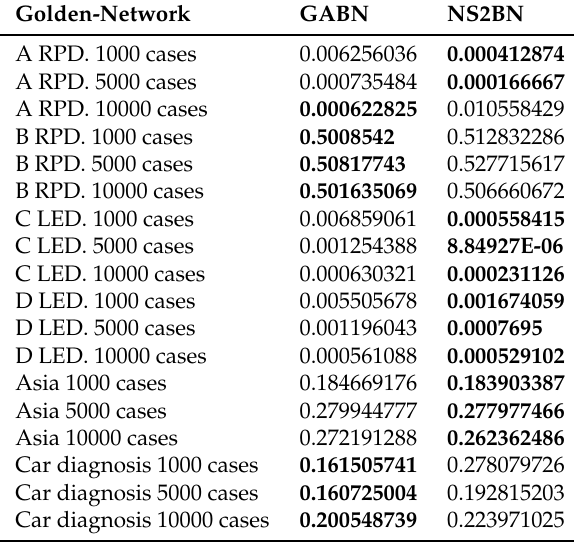
Table 3. Kullback–Leibler divergence computed between the gold-standard network with the GABN solution and the gold-standard network with the chosen solution of the NS2BN Pareto front. Values in boldface mean the best value